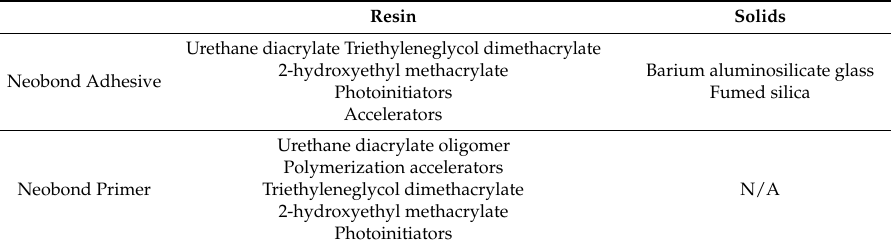
Table 1. Neobond orthodontic adhesive system.